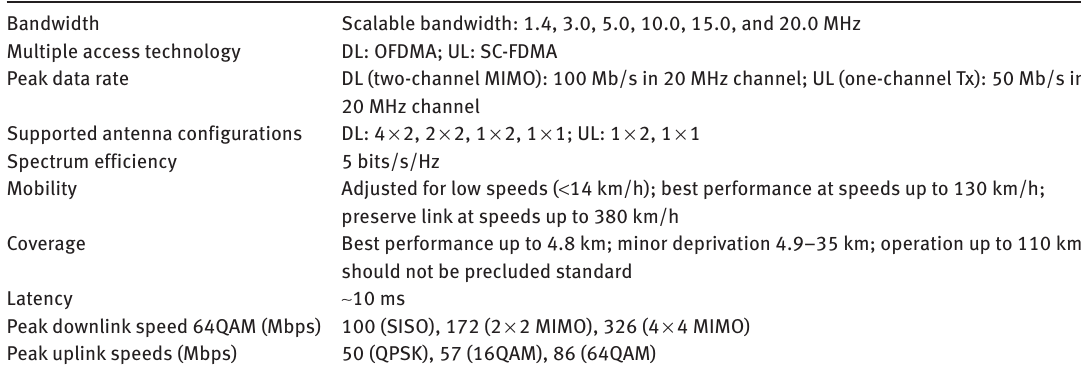
Figure 1: System Interface. Table 1: Technical Specification of the LTE Network.